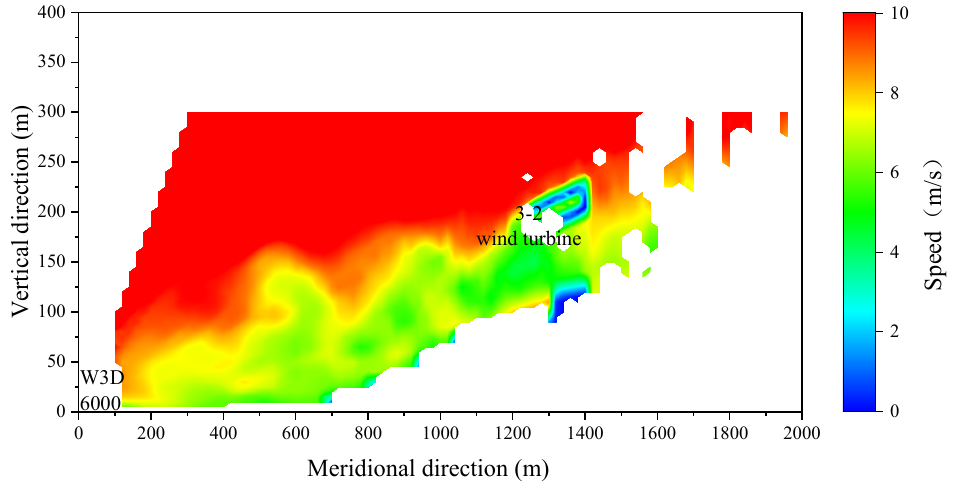
Figure 9. Cloud image of 3-2 wind turbine vertical profile measured by W3D6000. The incoming turbulence intensity I 0 = 0.11, the incoming wind speed u hub = 9 m/s at the hub center, the corresponding thrust coefficient C T = 0.749, and the wind shear index a = 0.14 were measured by WP350 for 10 min.